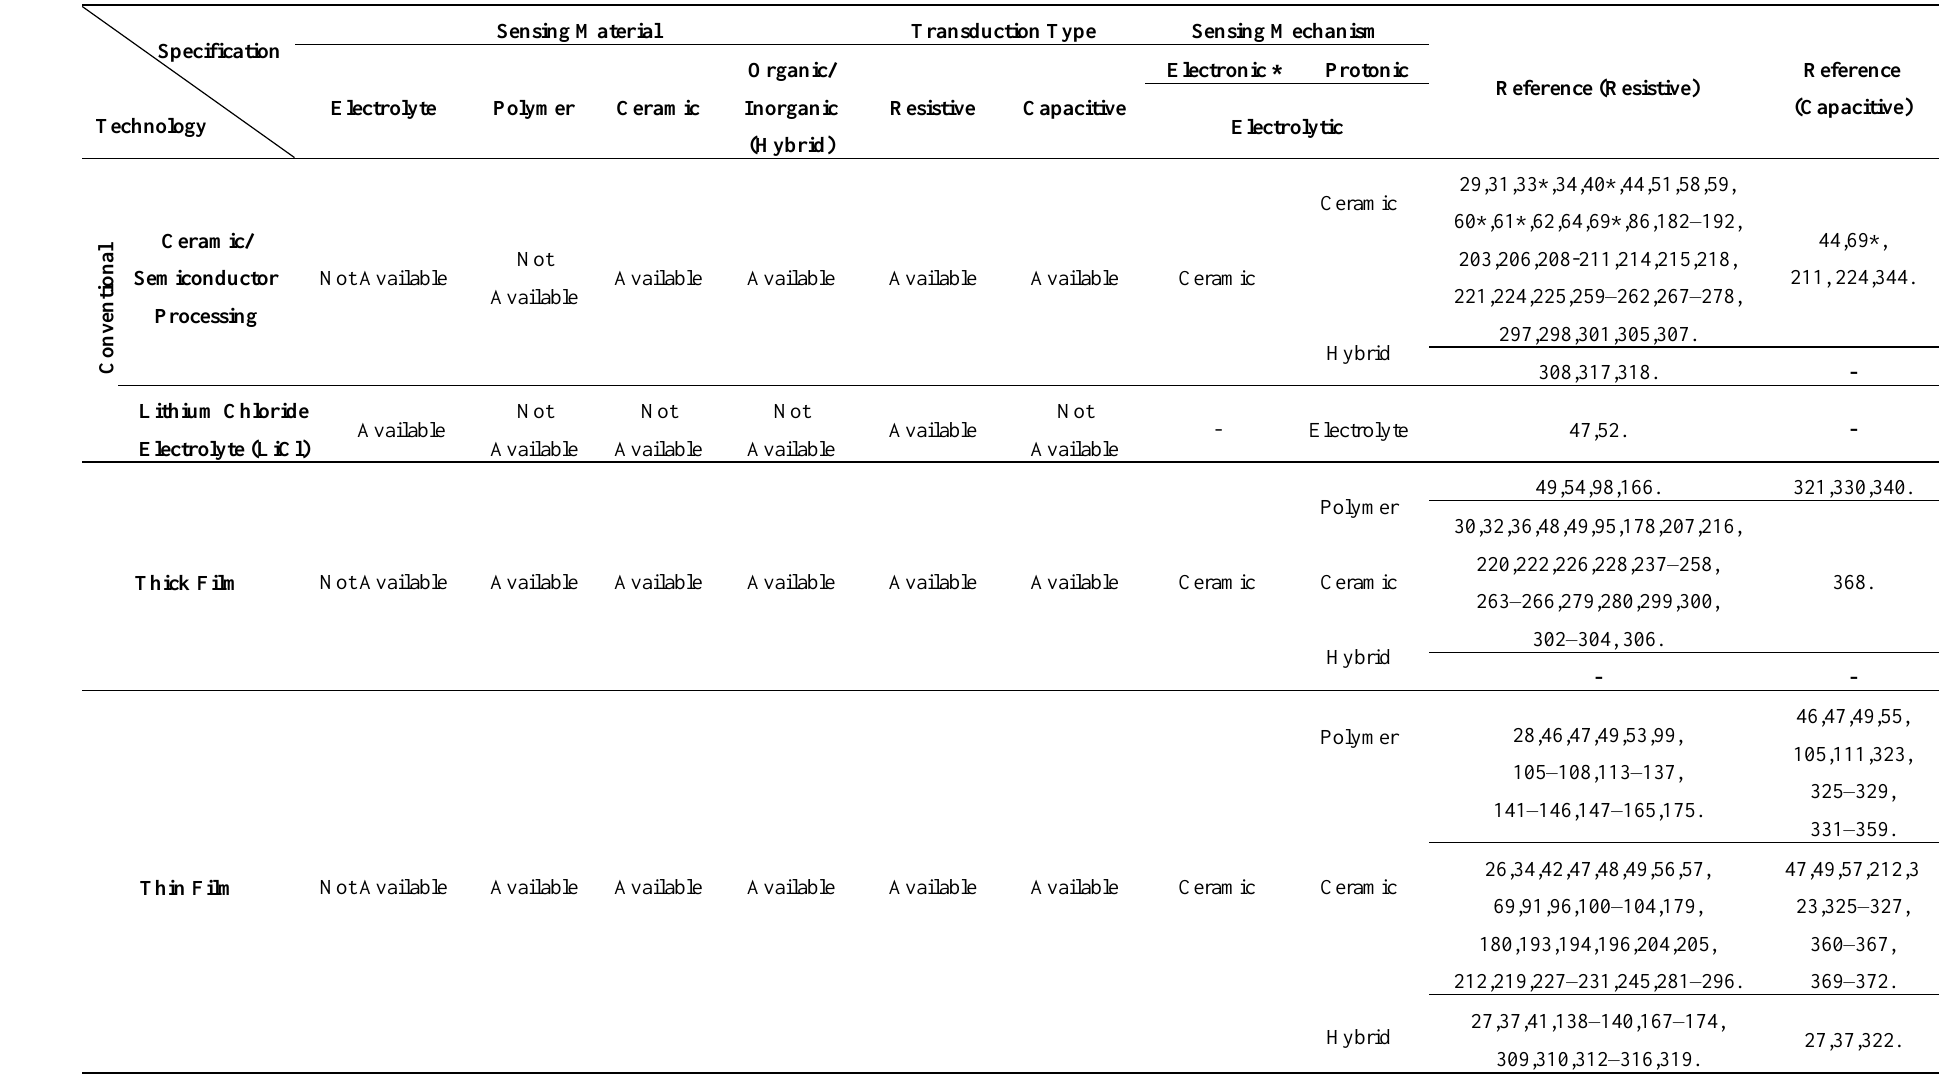
Table 2. Examples of the different relative humidity sensors based upon the technologies and